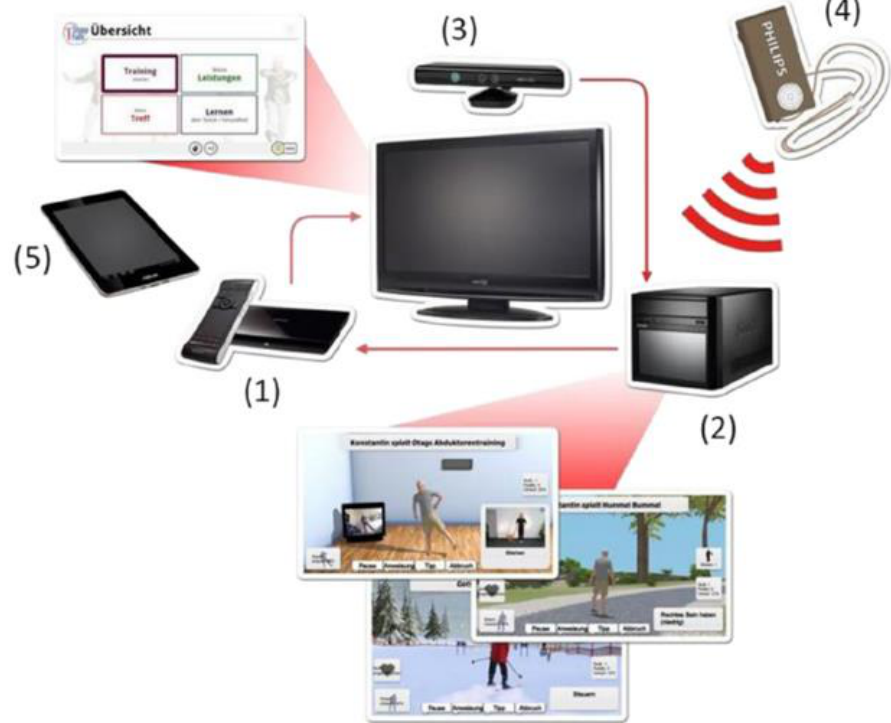
Figure 1. The different technologies integrated into the iStoppFalls ICT-based system. (Permission granted by the Dr Rainer. Wieching—PI, [57].) ( 1 ) Set top box (iTV), ( 2 ) mini-PC (exergame), ( 3 ) Kinect (gesture/voice), ( 4 ) Senior Mobility Monitor, ( 5 ) tablet (diary, control).